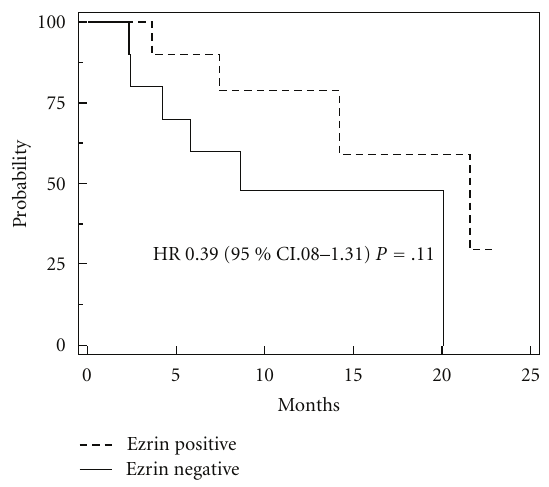
Figure 2: Overall survival according to immunohistochemical ezrin expression. Median overall survival for soft-tissue sarcomas patients whose tumors were classified as positive for ezrin was 21.1 months, compared to 8.6 months for ezrin-negative patients; HR 0.39, 95% CI 0.08–1.31; P = .